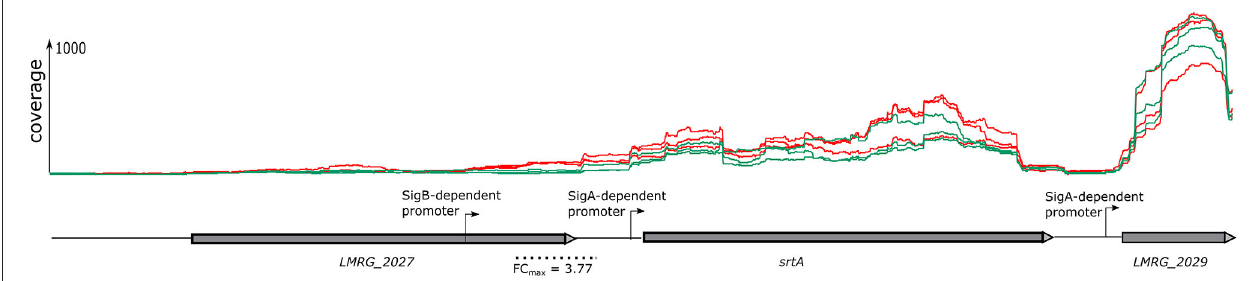
FIGURE 1 | Gene co-transcribed from both σ B -dependent and a σ A -dependent promoters. RNA-seq coverage is shown for the 1 BCHL P rha -sigB strain (red) and 1 BCHL-P rha strain (green). Transcription start sites (TSS) are indicated by arrows labeled with the regulating sigma factor. The dotted line below the schematic represents the region found to be differentially expressed (FDR < 0.05) with the sliding window approach. The highest window fold change (FC) is shown under the dotted